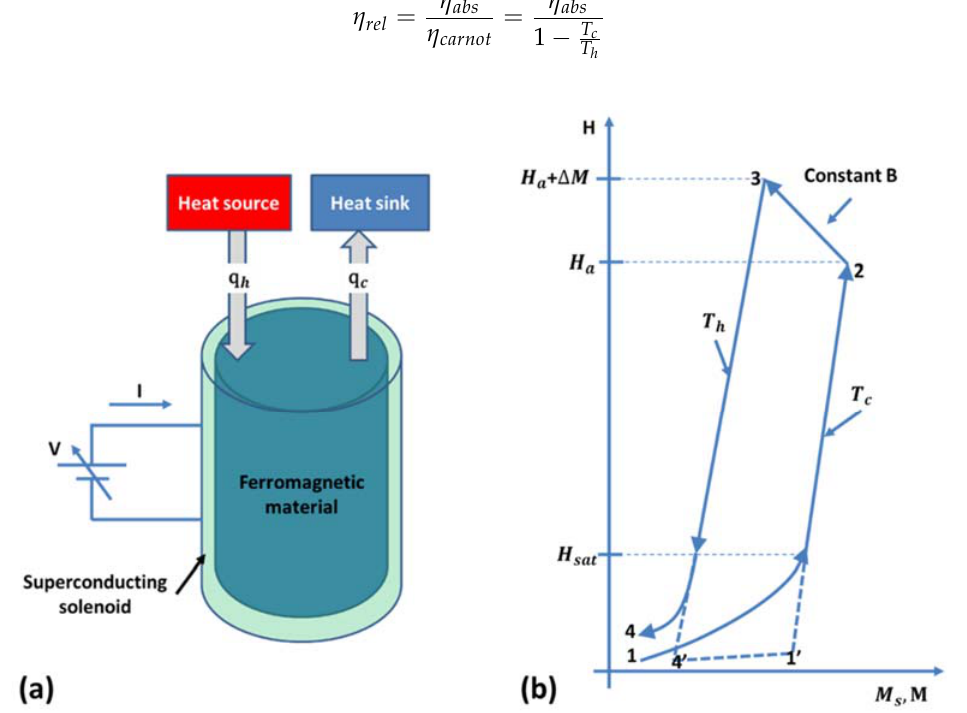
Figure 18. ( a ) A conceptual model of Solomon's thermomagnetic generator. ( b ) Thermomagnetic cycle. Adapted from [142], with permission from © 2018 Elsevier.